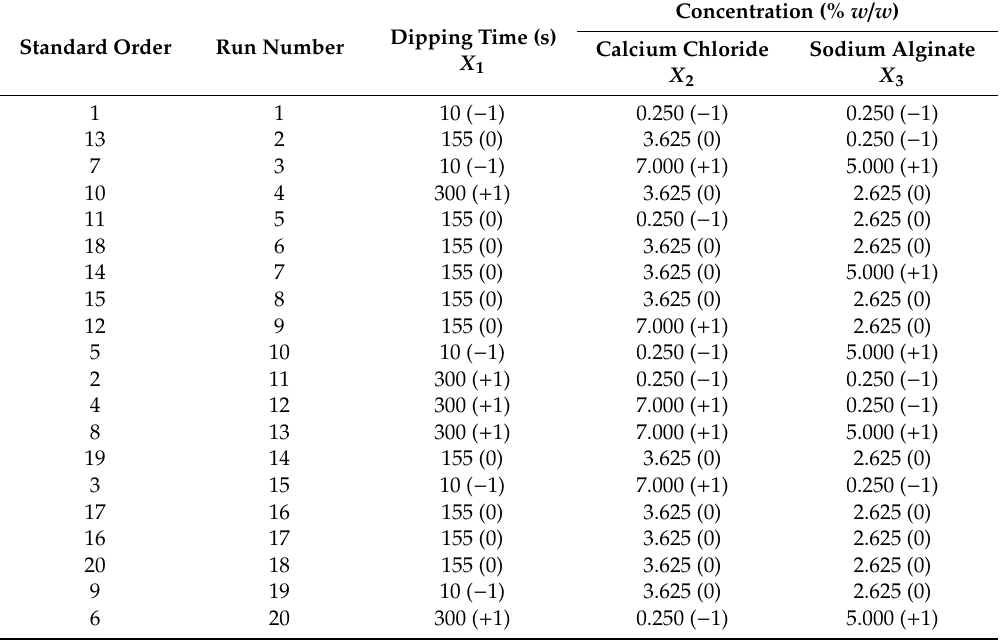
Table 1. The central composite design used, with the indication of the actual value and the coded level (in parenthesis) of the three